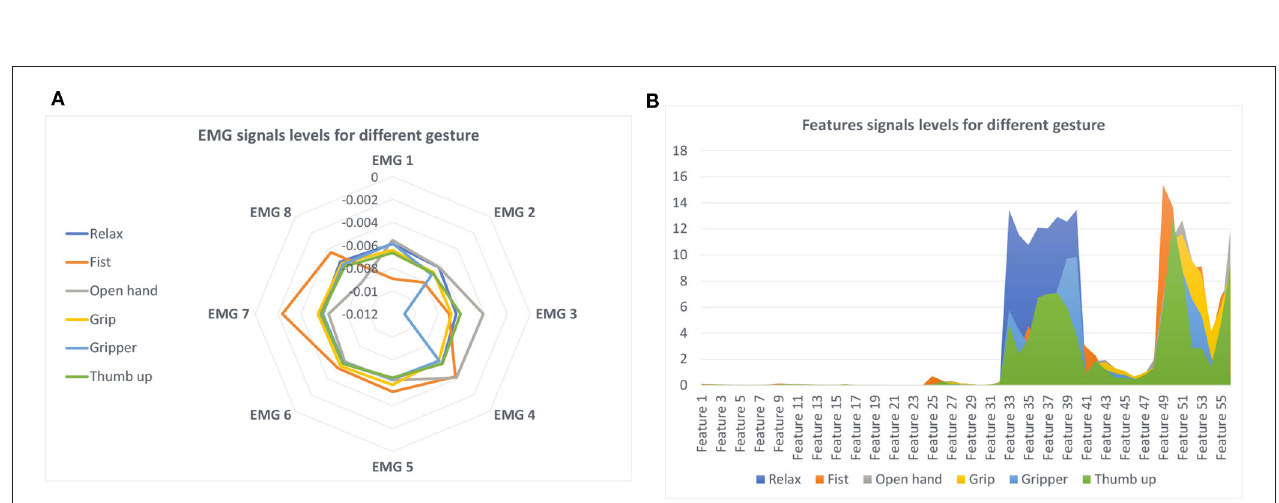
FIGURE 1 | Hand gestures performed during sEMG signal recording.